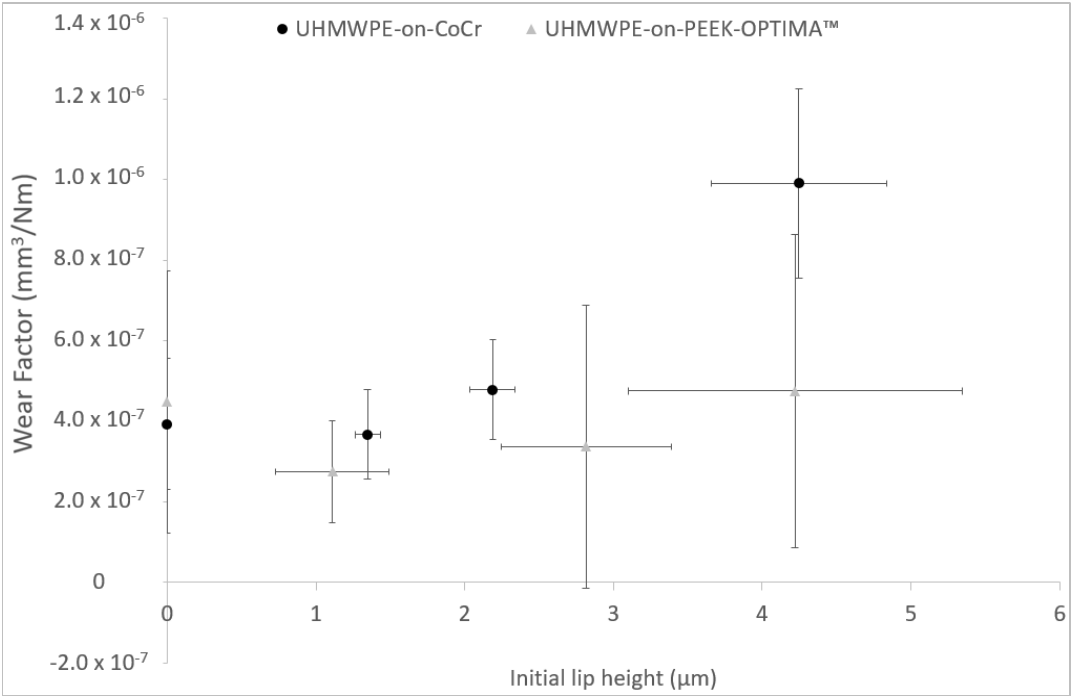
Figure 5. Mean wear factor (mm 3 /Nm) ± 95% confidence limits of UHMWPE pins tested against PEEK-OPTIMA™ and cobalt chrome plates scratched with a diamond stylus as a function of pre-test (initial) lip height, µm (± 95% confidence limits). Table 2. Mean lip height, µ m ( ± 95% confidence limits) of scratches on PEEK-OPTIMA ™ and cobalt chrome plates taken pre- and post- wear simulation (minimum N = 3). Statistical analysis to compare CoCr PEEK PEEK to CoCr, * denotes p <